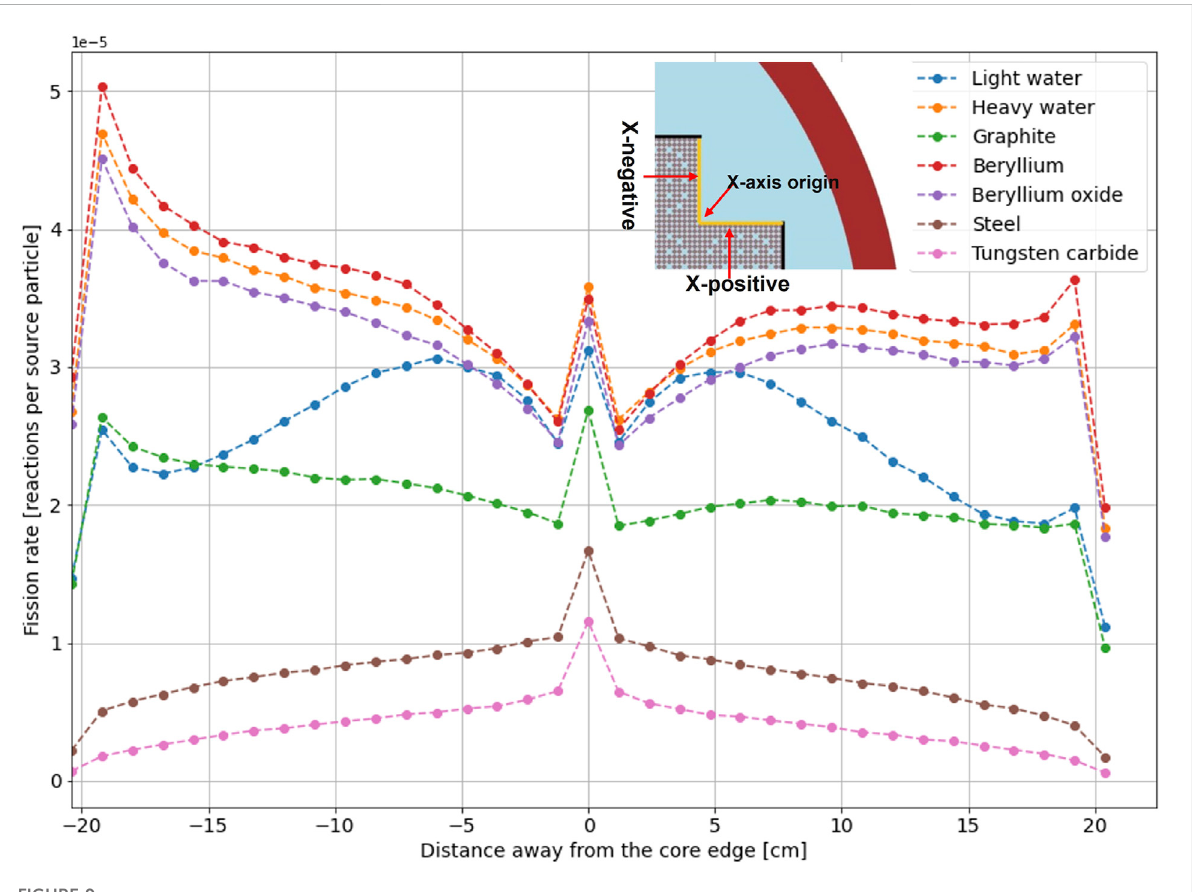
FIGURE 9 Fission rates among the boundary between the fuel assembly and re fl